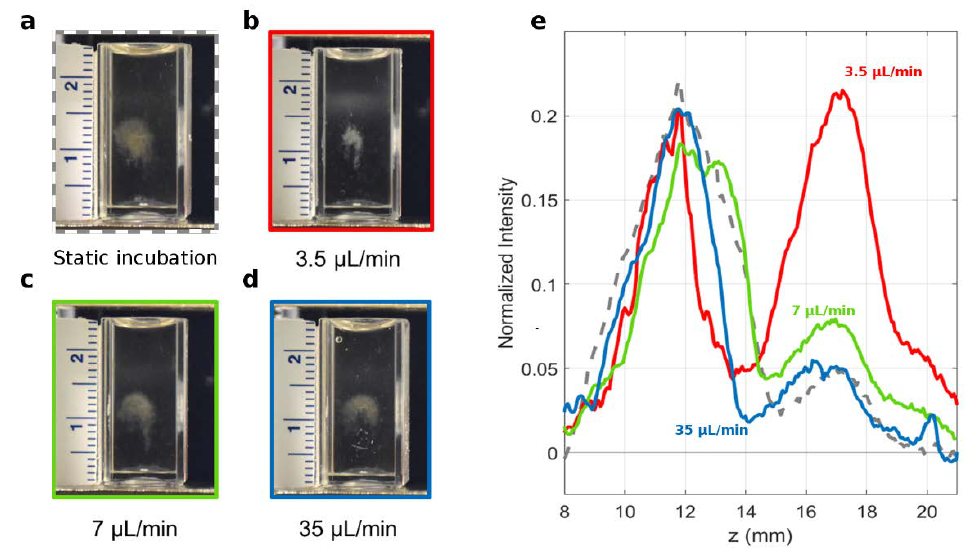
Figure 2. Representative MagLev patterns for GO-HP samples obtained via ( a ) static incubation and microfluidic incubation at ( b – d ) different flow rates. ( e ) Corresponding MagLev profiles of the investigated samples.